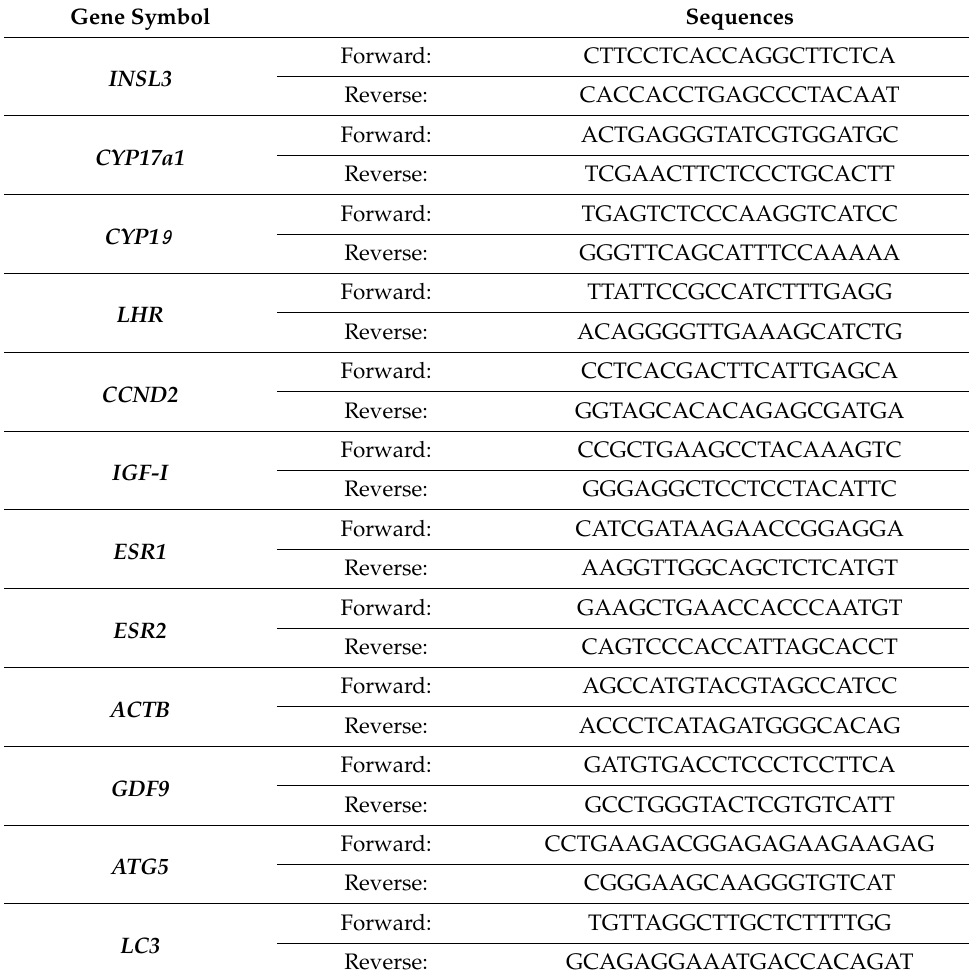
Table 1. Primers for real-time